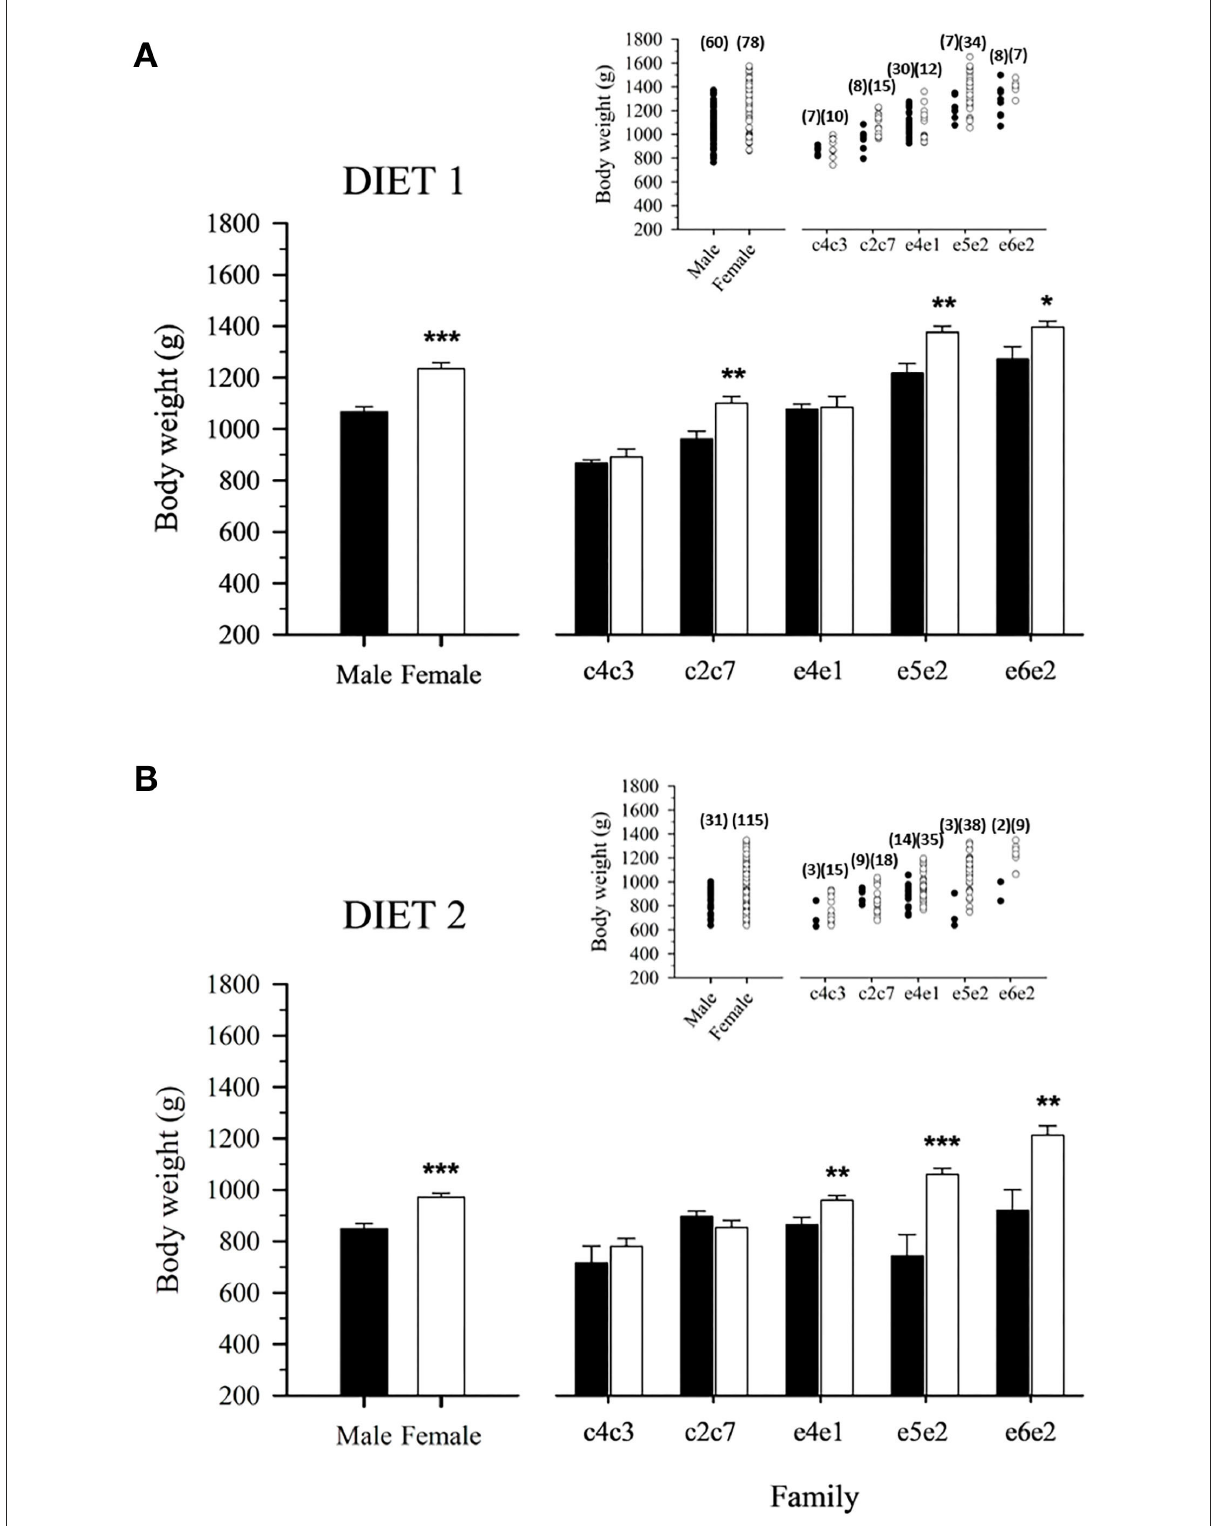
FIGURE3 Mean male and female body weight of 3-year-old gilthead sea bream-fed control (A) or experimental diet (B) as a whole population and separated by family. Values are the mean ± SEM of three tanks per diet ( n = 138 fish for diet 1, 146 for diet 2). Asterisks indicate significant differences (Student’s t -test, * P < 0.05, ** P < 0.01, *** P < 0.001) between males and females body weight. Inserts indicate individual body weight in each population. The number of males and females for the populations and families is indicated in